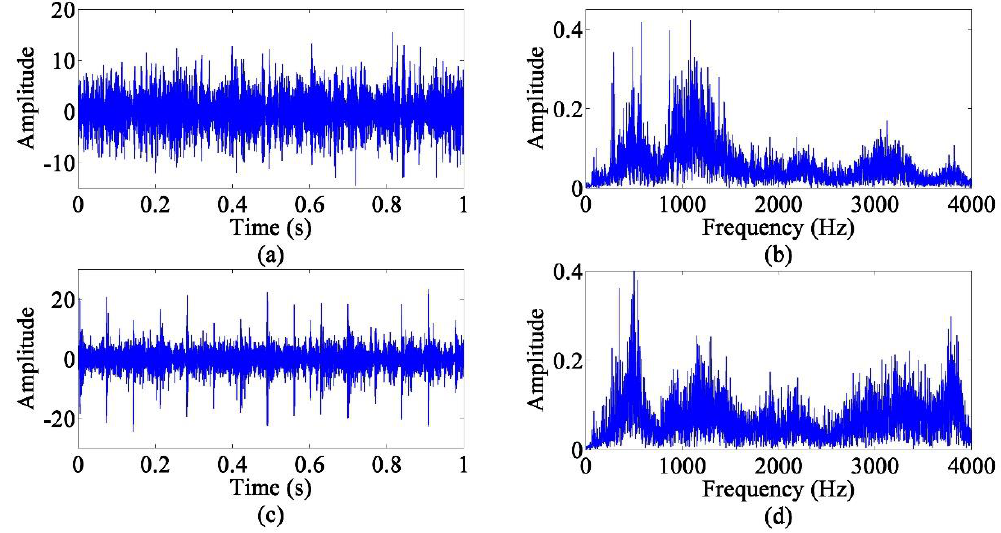
Figure 3. The time-domain waveforms and amplitude spectra of a healthy signal and faulty